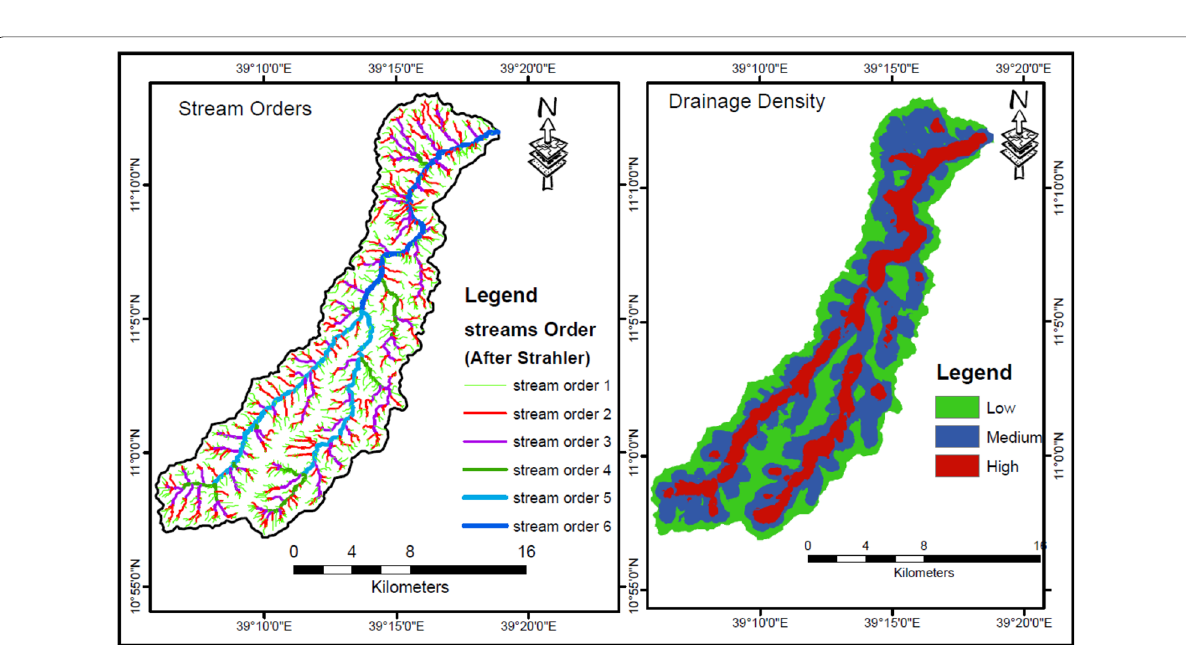
Fig. 2 Stream orders and drainage density of the Gedalas